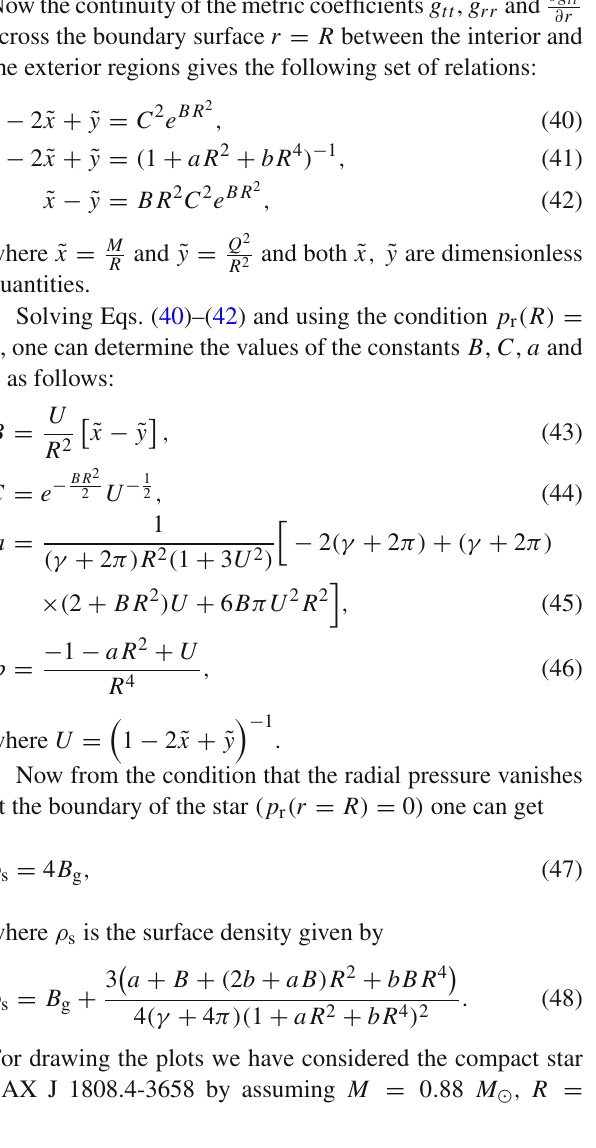
Table 1 The numerical values of central density, surface density, central pressure, relativistic adiabatic index, mass and effective surface redshift for different values of γ for the compact star SAX J1808.4-3658 by assuming M = 0 . 88 M (cid:2) , R = 8 . 9 km,